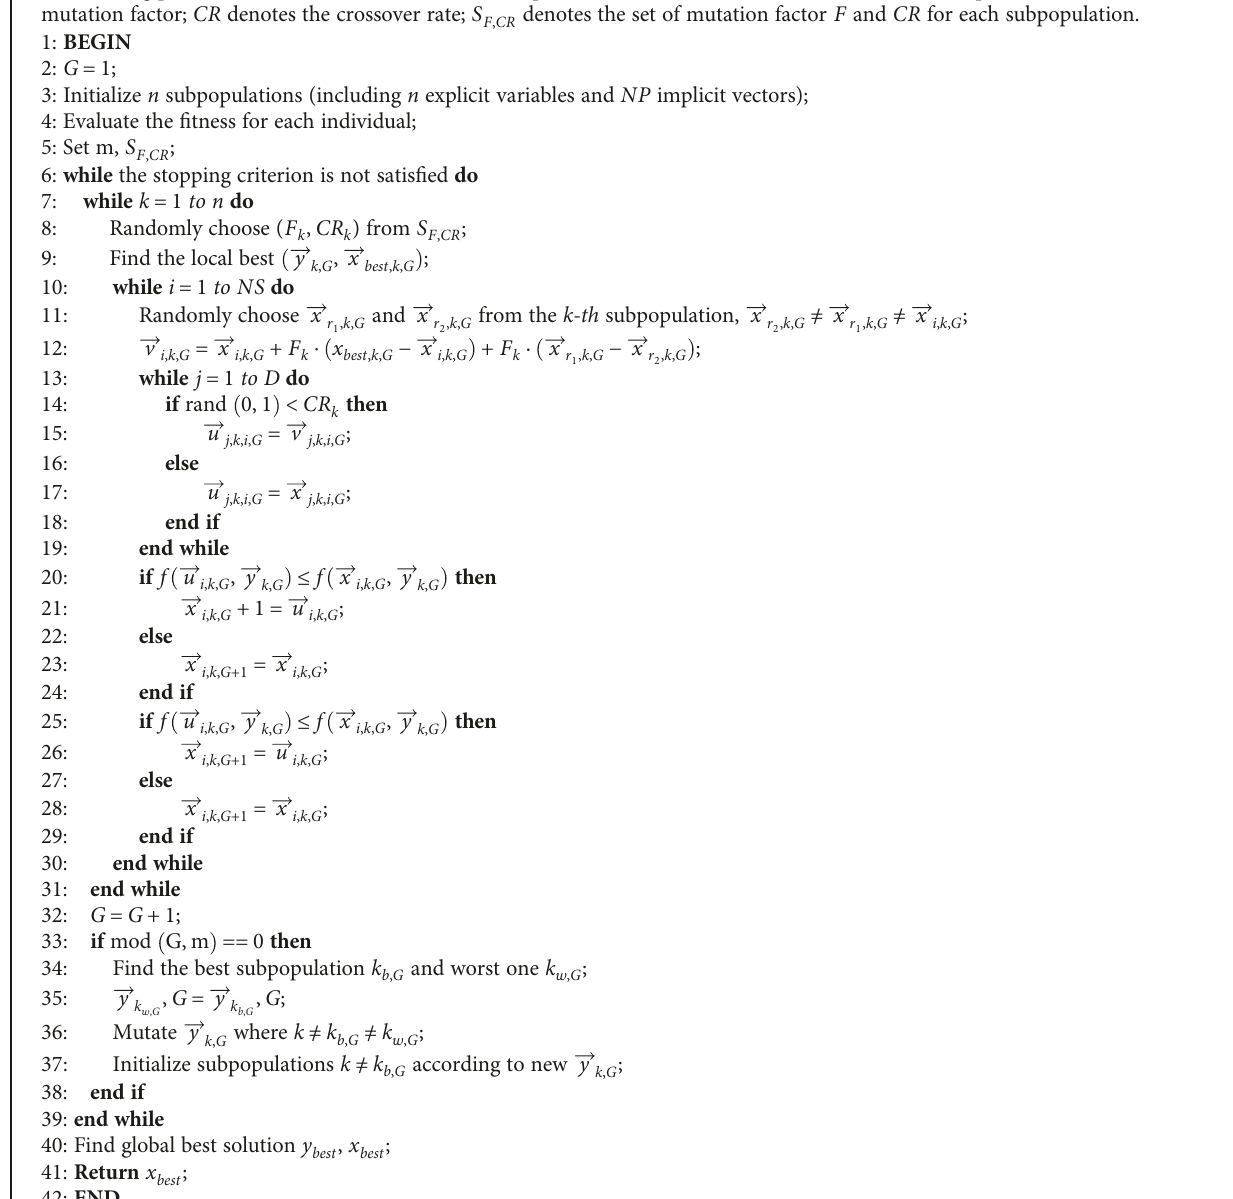
Algorithm 1: Pseudocode of